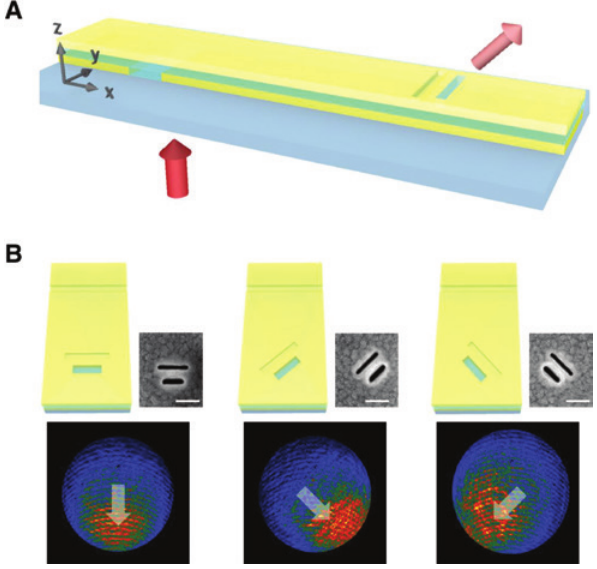
Figure 12: Integration of optical slot antennas with waveguides. (A) Schematics of optical slot antennas integrated to MIM plasmonic waveguides. The red arrows represent incident light launched from the bottom metal plane and radiation from the slot antennas to free space. (B) Schematics of optical slot Yagi-Uda antennas integrated to MIM waveguides (top left) and SEM images (top right) of the slot-groove structure that is parallel, rotated by 45 ° , and by −45 ° to the slit. The bottom images are the respective measured far-field radiation patterns. For ease of observation, thick white arrows are drawn on the measured images. White lines in the SEM images correspond to 200